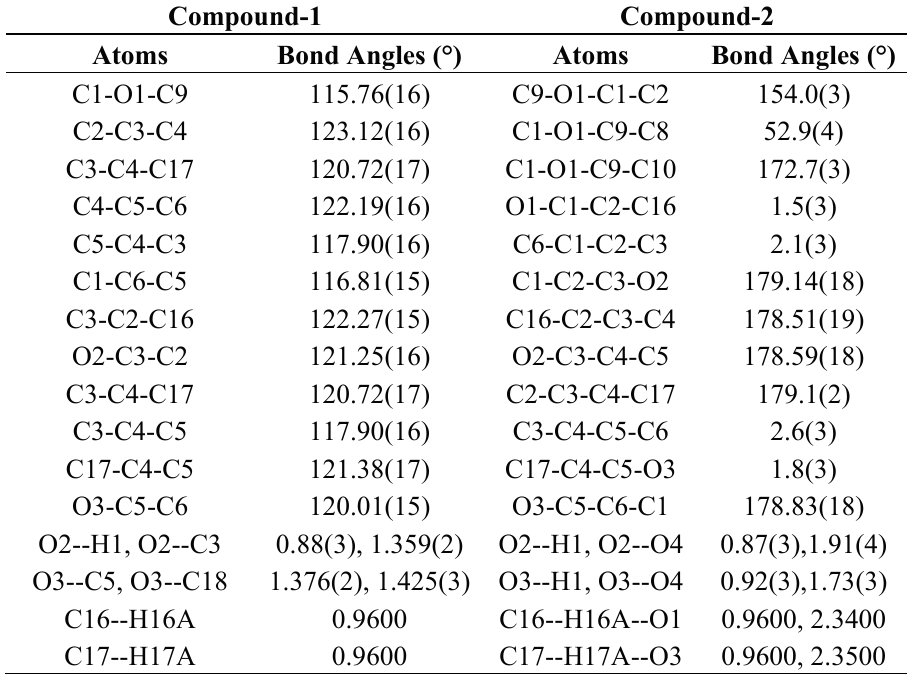
Table 2. Selected bond angles (°) of (2 S )-7-Hydroxy-5-methoxy-6,8-dimethyl flavanone and ( S )-6,8-dihydroxy-5,7-dimethyl